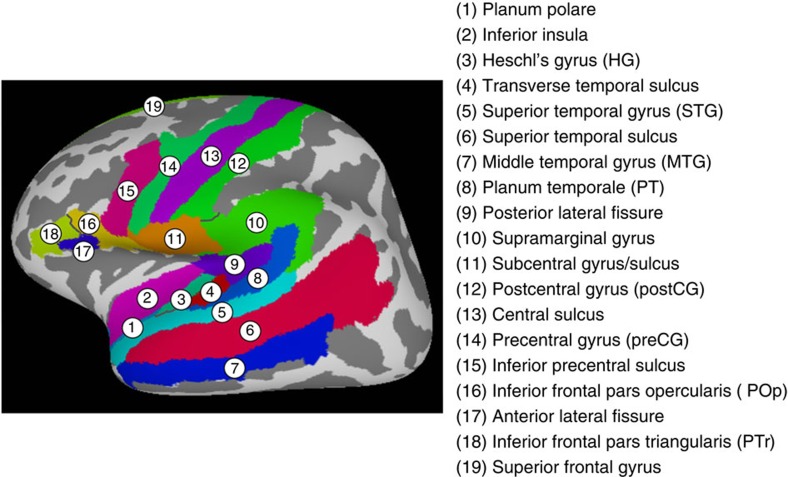
Speech-relevant anatomical ROIs used in multivoxel pattern analysis.The ROI mask consisting of 19 left and 19 right ROIs was created by intersecting a Neurosynth automated meta-analysis (search term: ‘speech') and the 148 Freesurfer anatomical ROIs (aparc 2009 atlas).